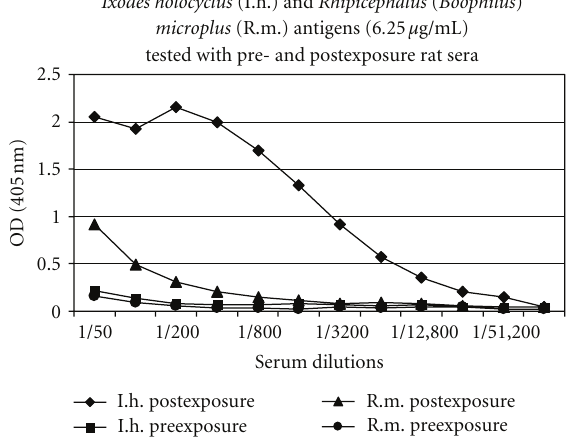
Figure 3: The reaction of rat sera to Ixodes antigen in ELISA after two exposures to I. holocyclus ticks. Preexposure (negative) and postexposure (positive) rat serum was titrated in doubling dilutions and tested against Ixodes and Rhipicephalus antigen in ELISA using the optimal conditions and protocol described